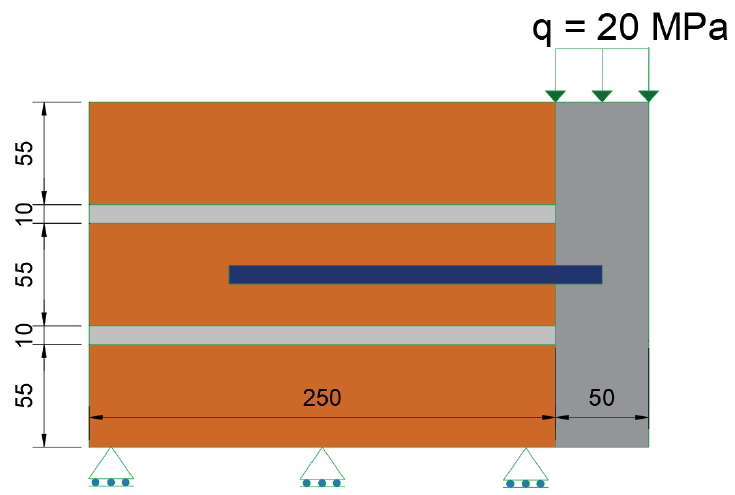
Figure 16. Geometry, loads, and boundary